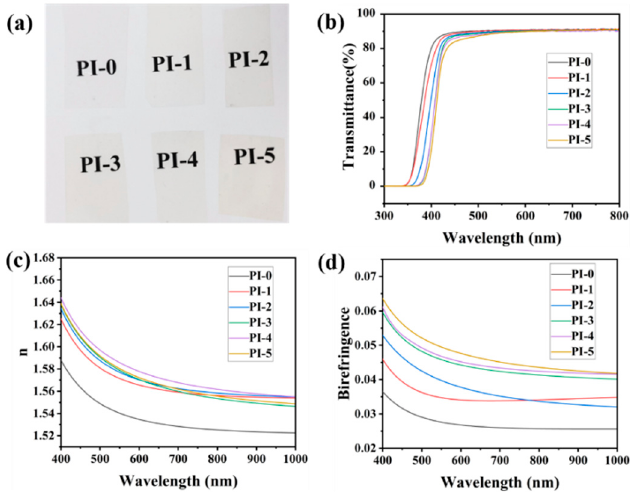
Figure 3. ( a ) The picture of the CPIs; ( b ) The UV–Visible spectrum of CPIs; ( c ) The average refractive index (400–1000 nm) of CPIs; ( d ) The refractive index (400–1000 nm) of CPIs. Table 1. The optical properties of the